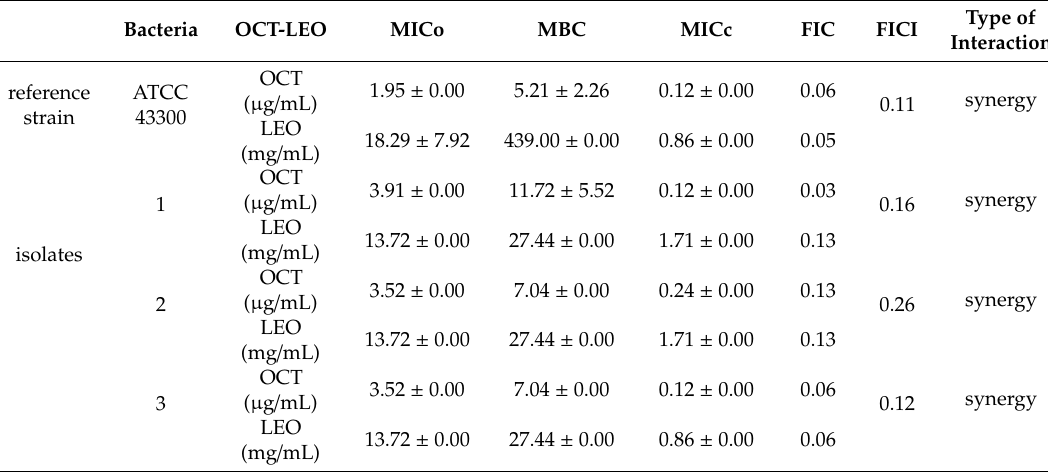
Table 2. Fractional inhibitory concentration (FIC) and FIC indices (FICI) of octenidine dihydrochloride (OCT)—lavender essential oil (LEO) pairs against methicillin-resistant Staphylococcus aureus (MRSA) strains.